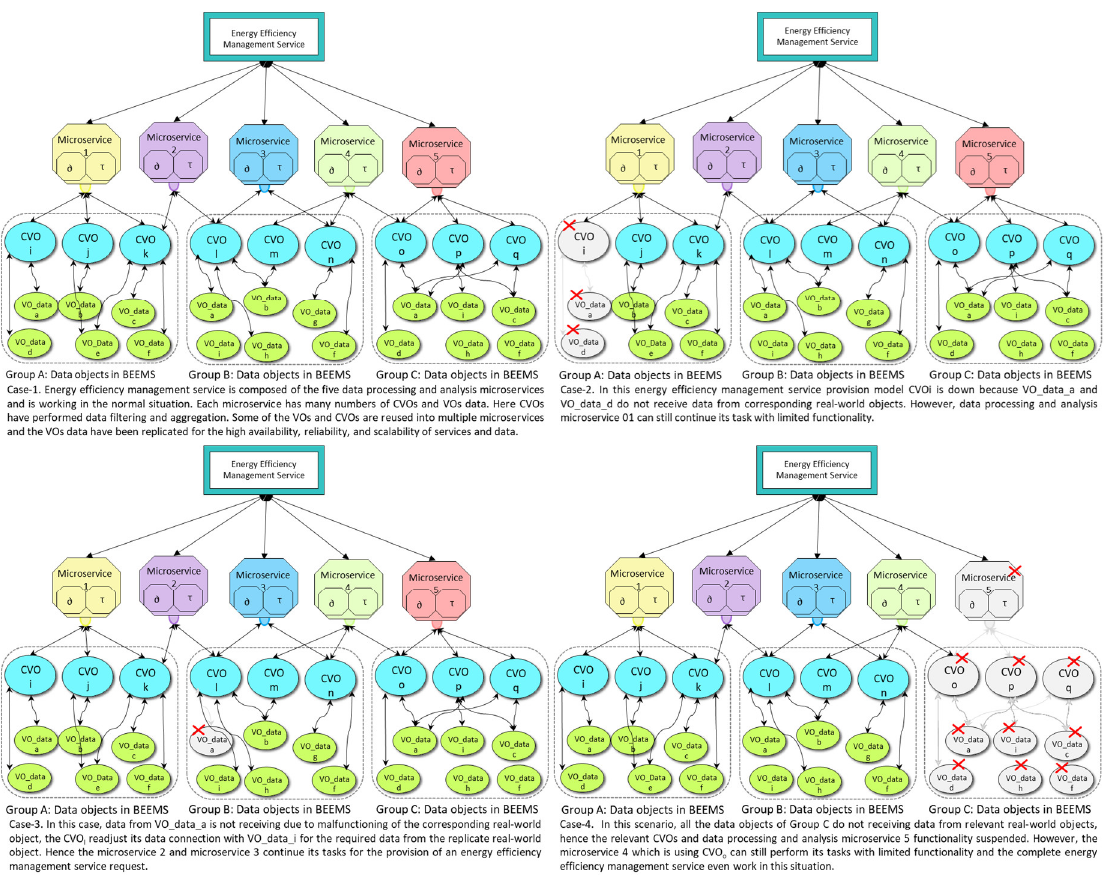
Figure 6. Microservices model to enhance data availability and services for BEEMS.